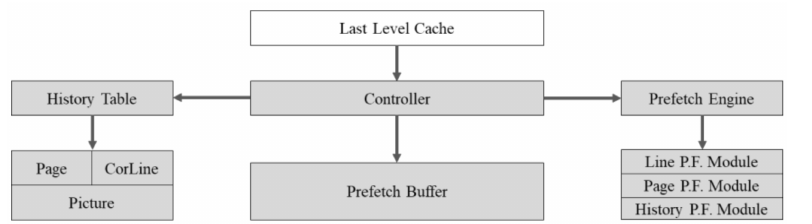
Figure 5. Controller.